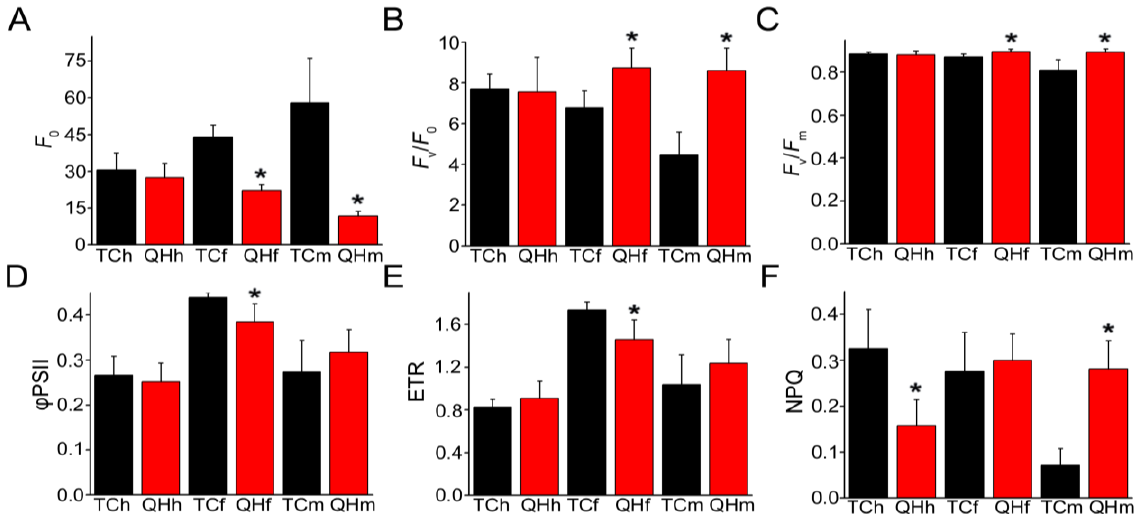
Figure 3. Chlorophyll fluorescence parameters of bracts during oat bract development. ( A ) F 0 , the minimum fluorescence; ( B ) F v / F 0 , PSII potential photosynthetic activity; ( C ) F v / F m , PSII maximum photochemical efficiency; ( D ) φPSII, actual PSII photochemical efficiency; ( E ) ETR, PSII electron transfer rate; ( F ) NPQ, non-photochemical quenching. The asterisk represents the difference in ‘Triple Crown’ and ‘Qinghai 444’ bracts (* p ˂ 0.05, Student’s t- test), with 3 replicates.